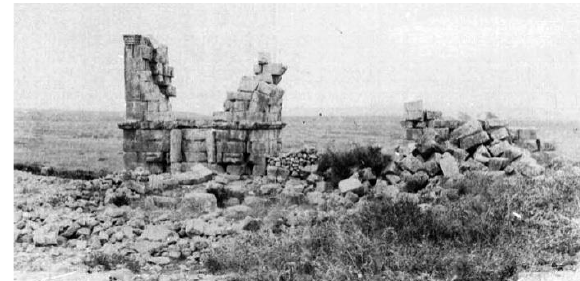
Figure 4. Photo taken by H. de la Martinière